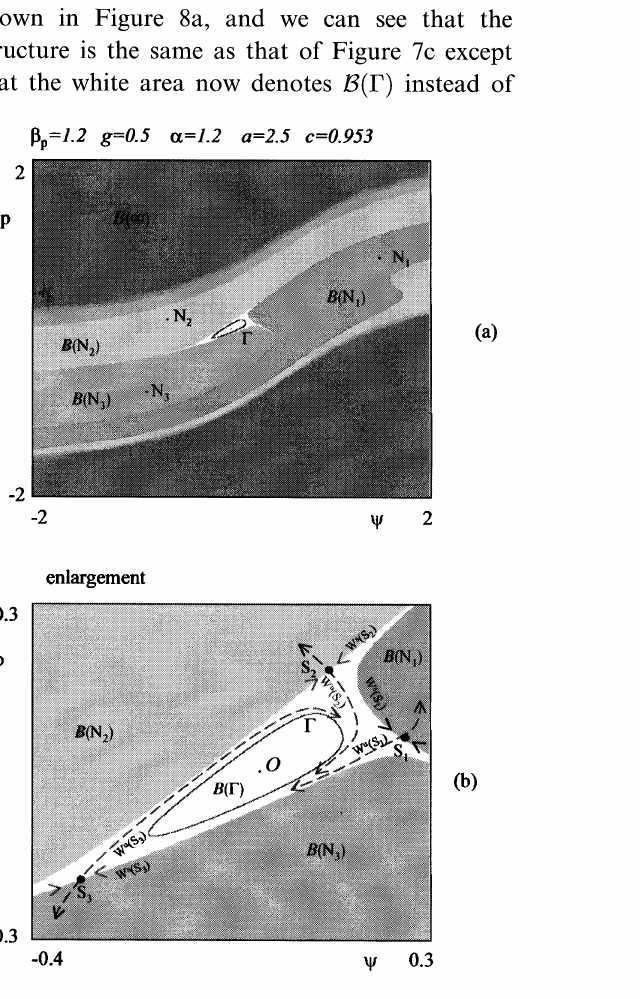
FIGURE 8 Starting from Figure 7c, where tip 1.2, g =0.5, c= 1.2, a=2.5, c-0.95, the crossing of the Neimark-Hopf bifurcation curve observed by slightly increasing c leads to the creation of a closed invariant curve F, represented in (a) for c-0.953. The enlargement in (b) shows that the basin of F is bounded by the stable sets W(Si) of the saddle points Si, 1,2, 3, while the unstable set Wu(Si) of each saddle Si has one branch converging to N; and the other converging to F. (See Color Plate